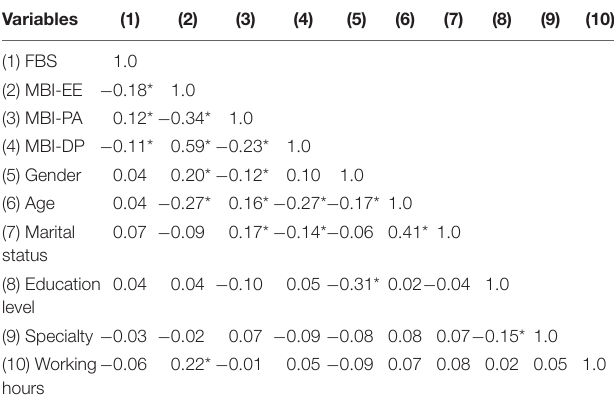
TABLE 3 | Spearman’s rank correlation coefficients for FBS, MBI dimensions and socio-demographic information (* p < 0.05).